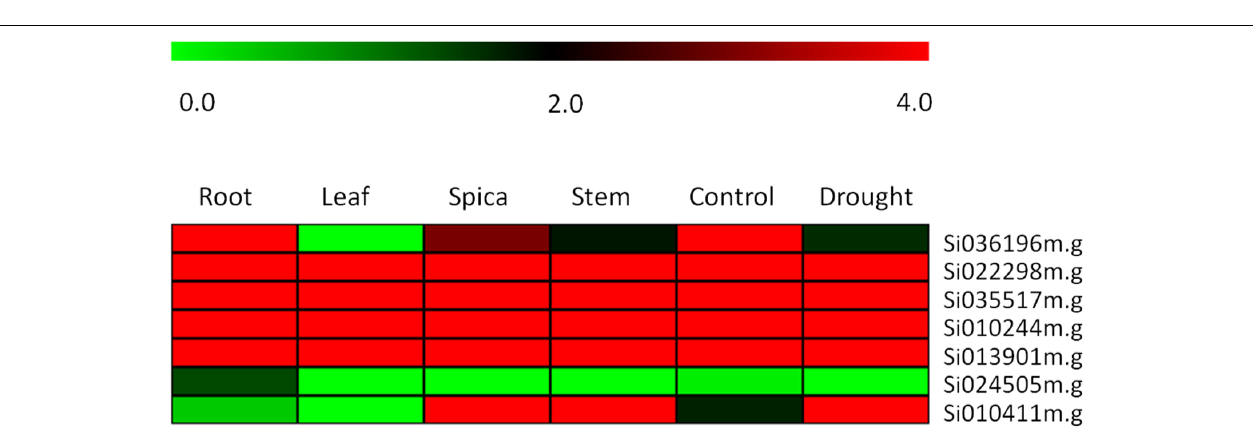
FIGURE 4 | The distribution of zinc and iron responsive (TF) transcription factors across ZIP in S. italica.